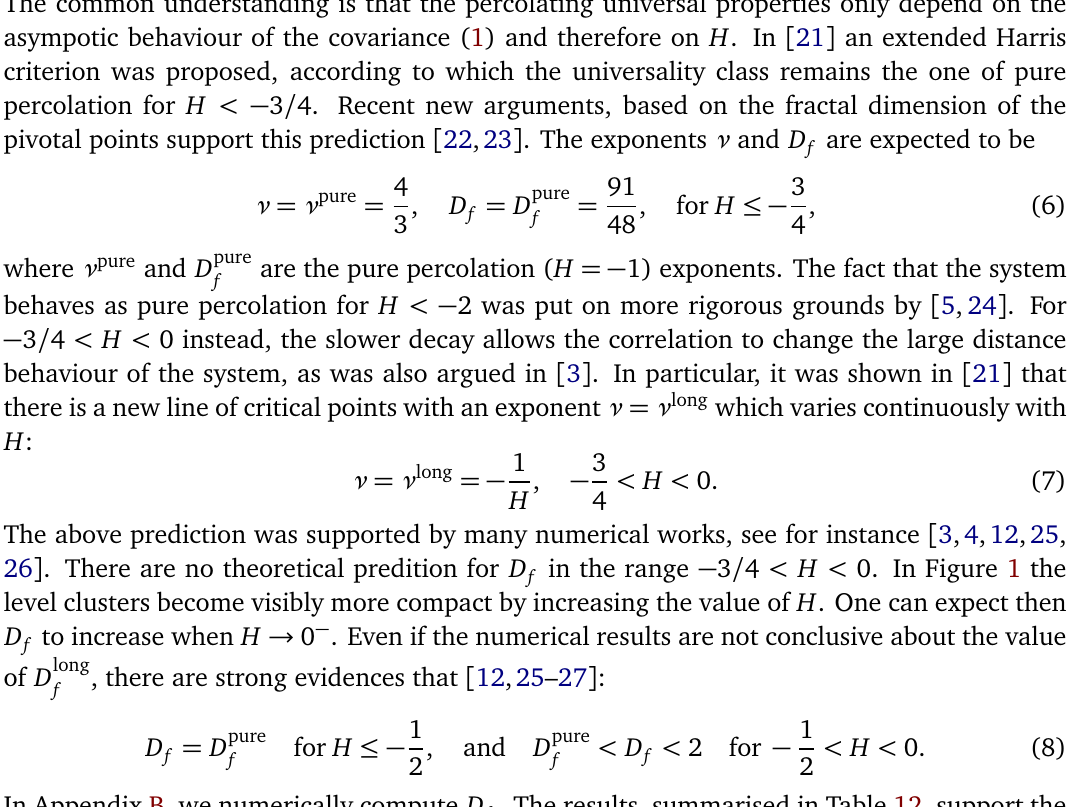
from Table 10 are c → 2 for f